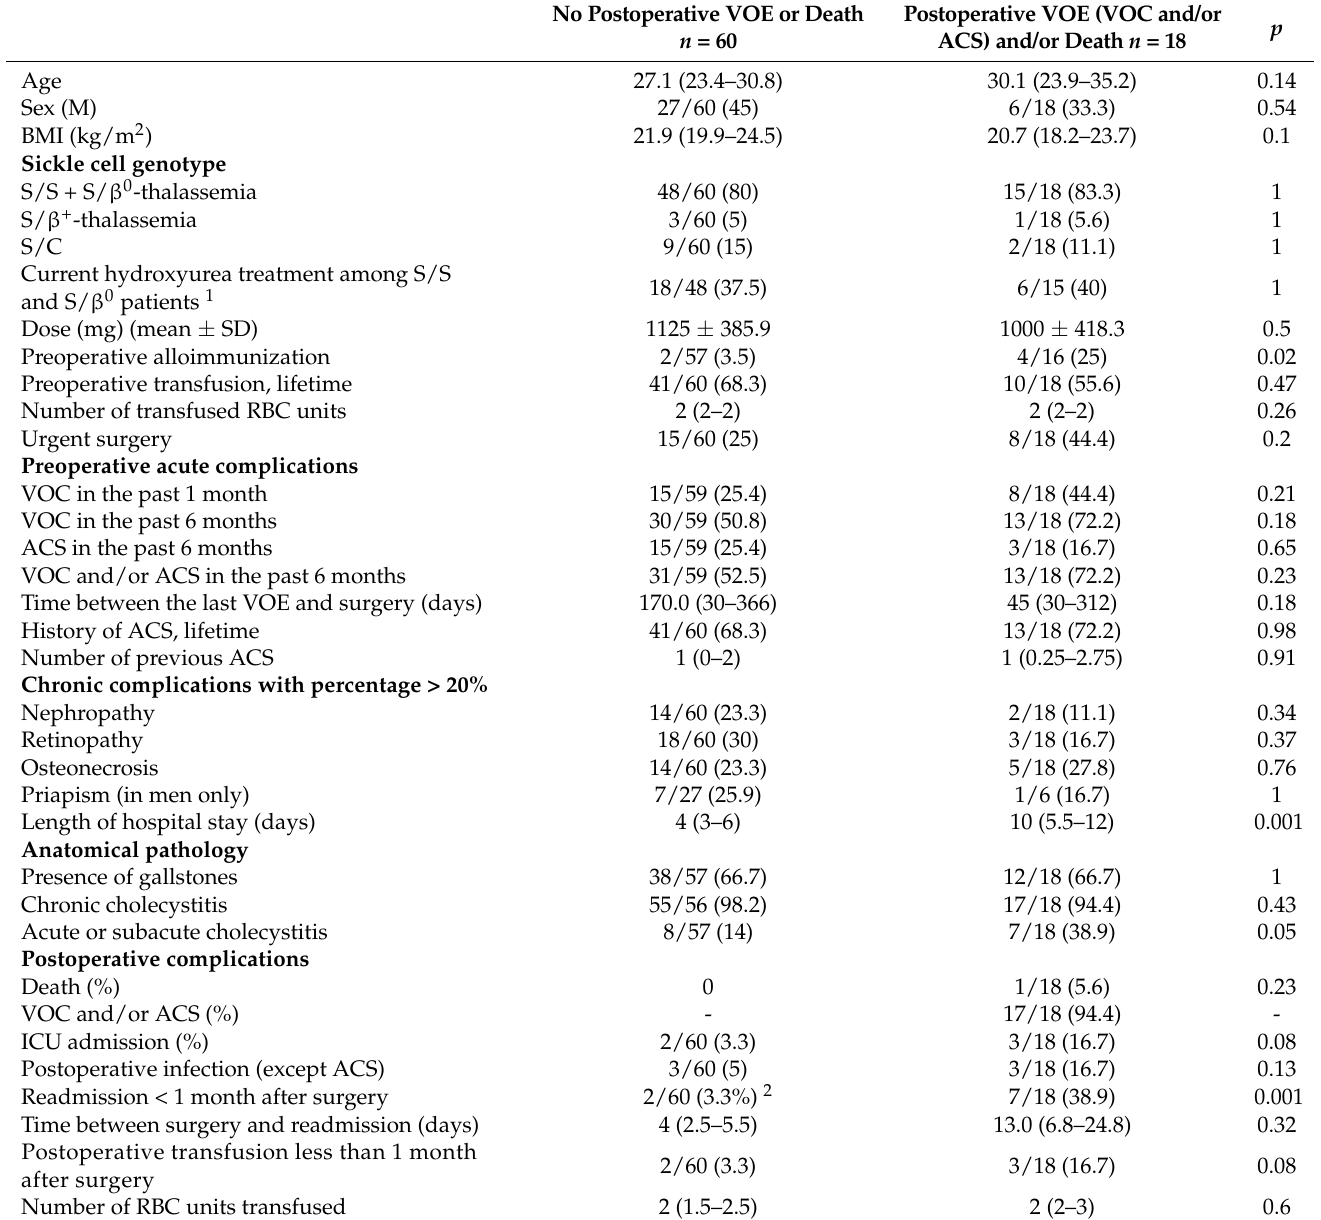
Table A2. Comparison of patients according to postoperative vaso-occlusive events (VOC and/or ACS) and/or